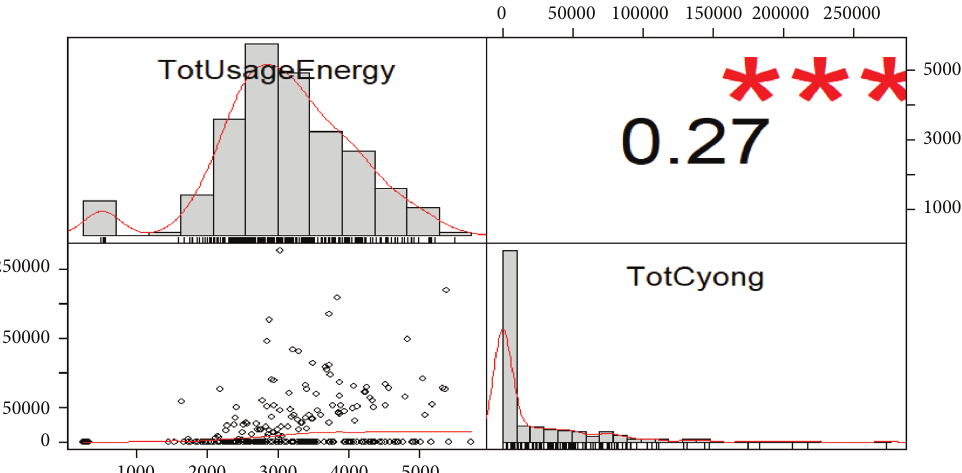
Figure 13: Diagram showing correlations values of total usages of energy and total Cyong